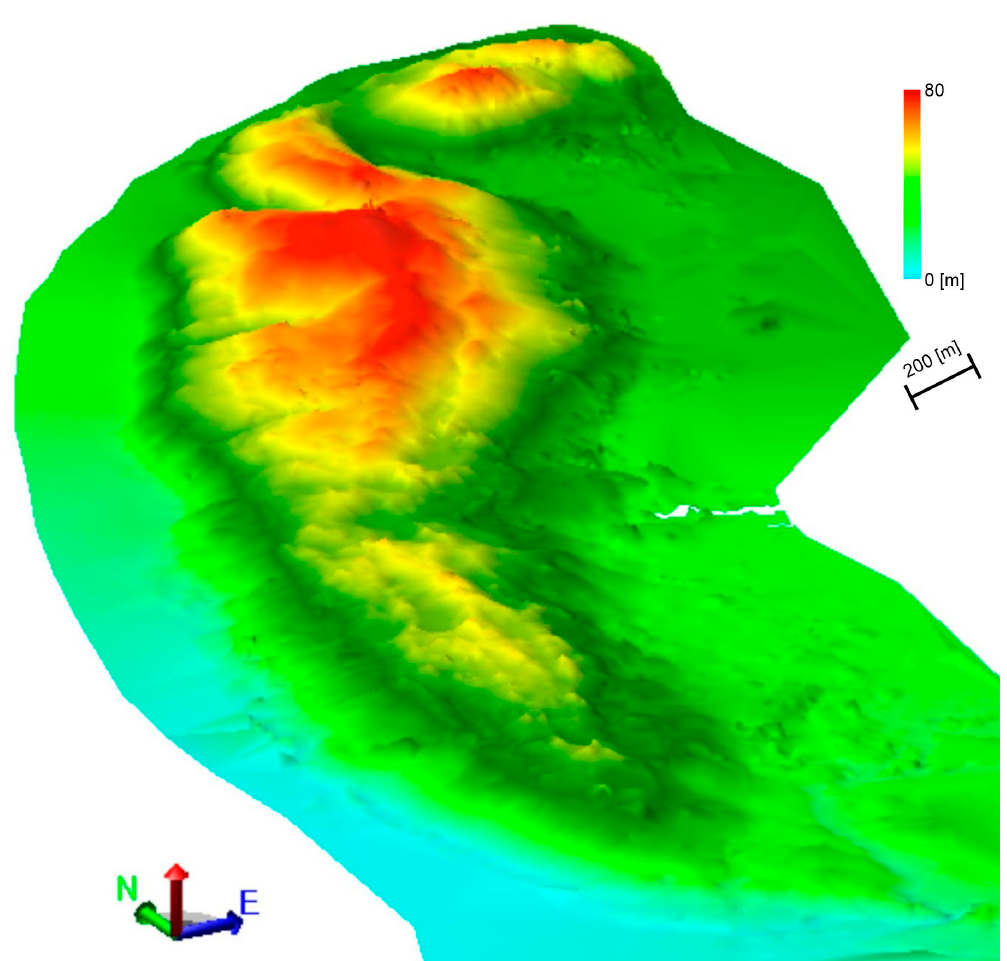
Figure 3. Digital terrain model of the terrain of the glacier end moraine developed from direct surveys in 2015.